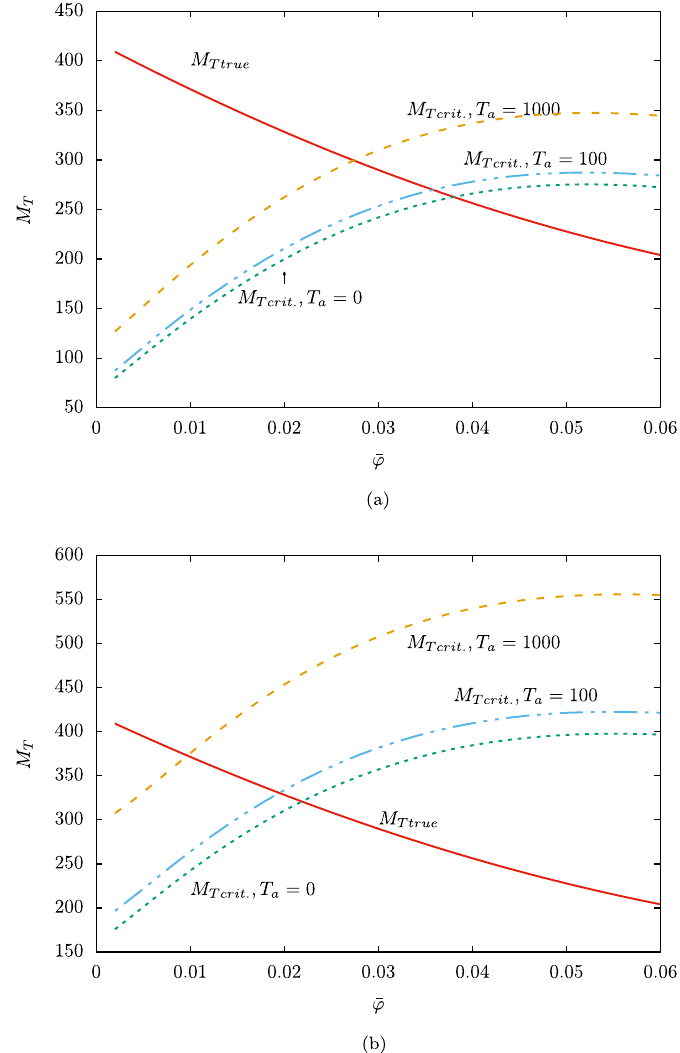
Figure 3: The true and critical temperature Marangoni numbers for DW/cupric oxide nano fl uid with = d 30 nm p , = T Δ 2°K for average volume fractions ranging from 0.01 to 0.06. Stability boundary curves for the temperature Marangoni number are calculated based on ( a ) Model I and ( b ) Model II, using thermal conductivity and dynamic viscosity constitutive functions proposed by Brinkman - Hamilton -